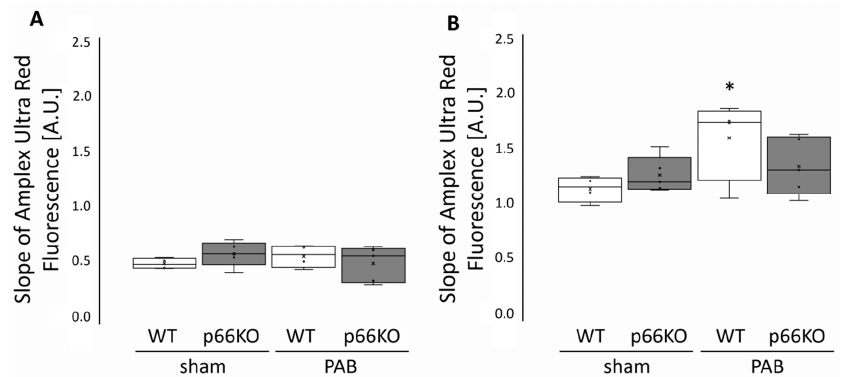
Figure 1. ROS formation in mitochondria isolated from mice three weeks after pulmonary artery banding (PAB) or sham surgery. ( A ) Basal and ( B ) rotenone-stimulated reactive oxygen species (ROS) production in right ventricular (RV) mitochondria. ROS formation was measured as the slope of Amplex Ultra Red fluorescence over time in arbitrary units (A.U.). Data are given for wild type (WT) and p66shc knockout (p66KO) mice three weeks after sham surgery ( n = 4 and n = 5, respectively) and for WT and p66KO mice three weeks after PAB ( n = 6 and n = 5, respectively). Data are expressed as 25%, 50%, and 75% quartiles with whiskers representing the total range. The dots represent the individual data points. *: p < 0.05 vs. WT sham as analyzed by two-way ANOVA.